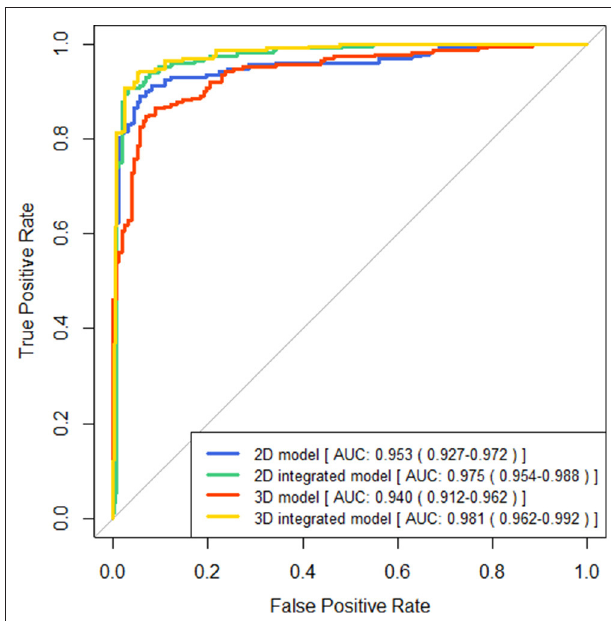
FIGURE 4 | Comparisons of receiver operating characteristics (ROC) curves generated by brain atrophy models for two-type classification.